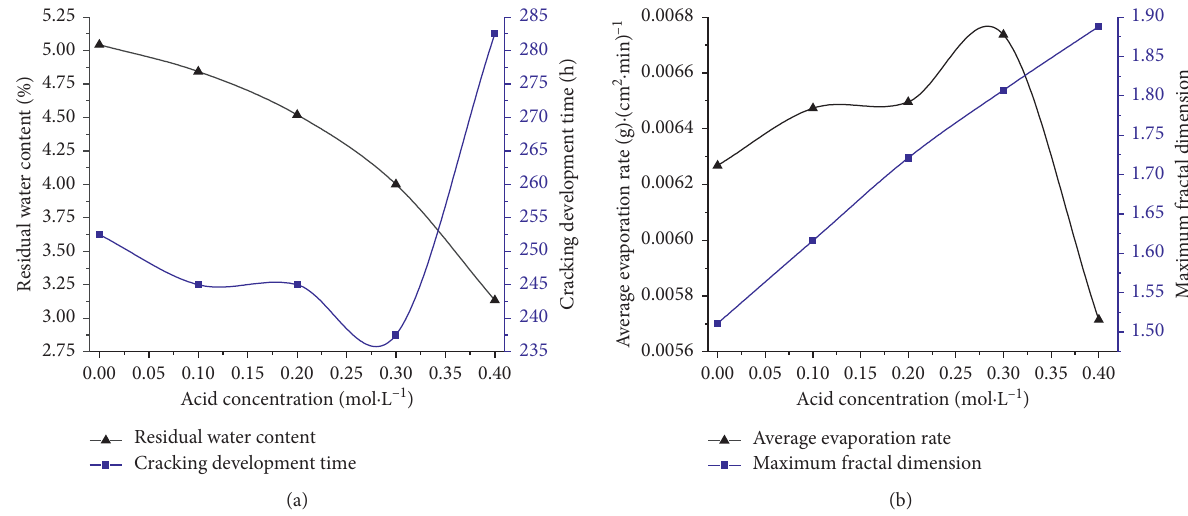
Figure 8: Residual water content, average evaporation rate, and maximum fractal dimension of cracks of contaminated samples with different acid concentrations: (a) residual water content, and (b) maximum fractal